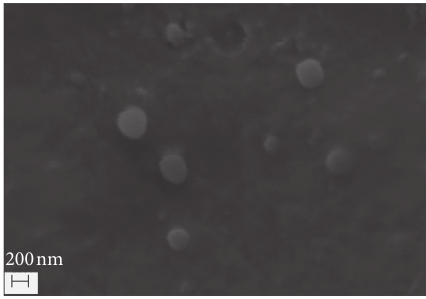
Figure 1: Scanning electron micrograph of folic acid encapsulated submicron particles.